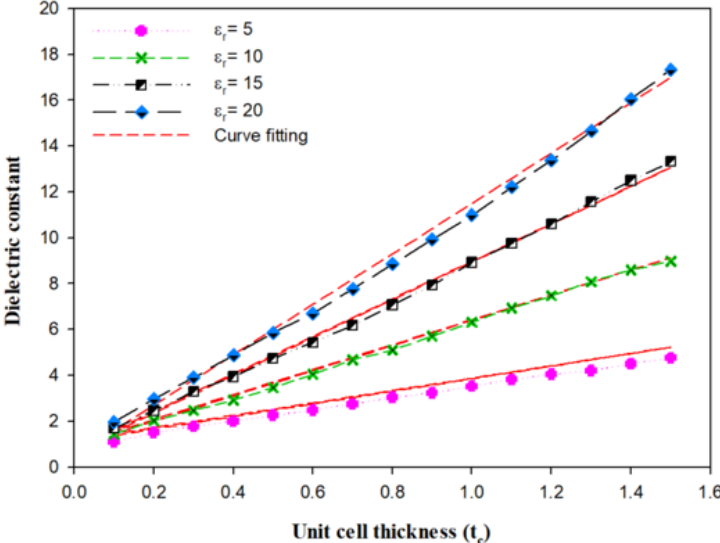
Figure 16. Effective relative permittivity of perforated hemispherical DRA